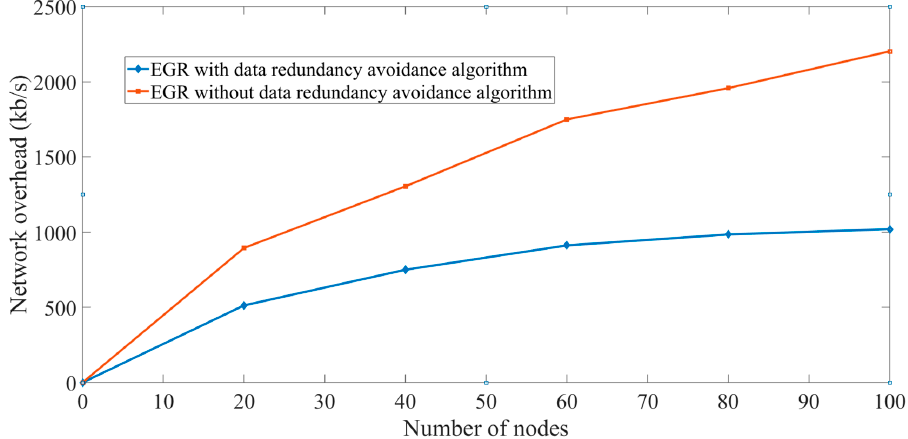
Figure 20. Cluster formation time.